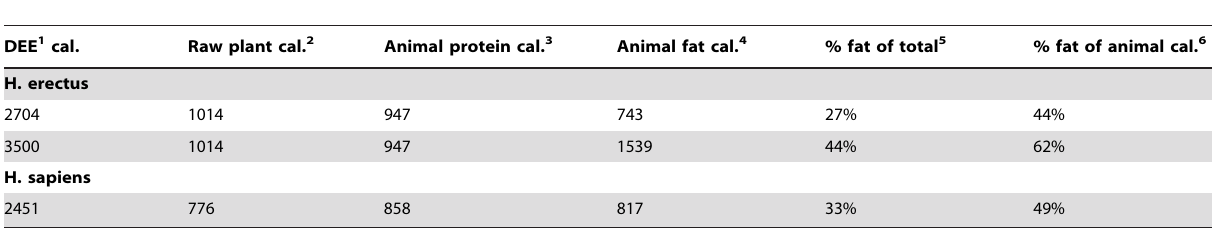
Table Notes. 1 DEE – Daily Energy Expenditure. After Leonard and Robertson ([156]:275) adjusted for average gender controlled weight per McHenry ([5]:258; and see and Table S1). 2 37.5% and 31.7% of DEE for H. erectus and H. sapiens respectively, based on equation above. 3 After Cordain et al. ([53]), based on Rudman et al. ([58]) and adjusted for body weight. 4 DEE minus calories supplied by consumption of animal protein and plant sources. 5 Animal fat calories divided by total calories obtained from all food sources. 6 Animal fat calories divided by total calories obtained from animal sources alone. doi:10.1371/journal.pone.0028689.t002 PLoS ONE |